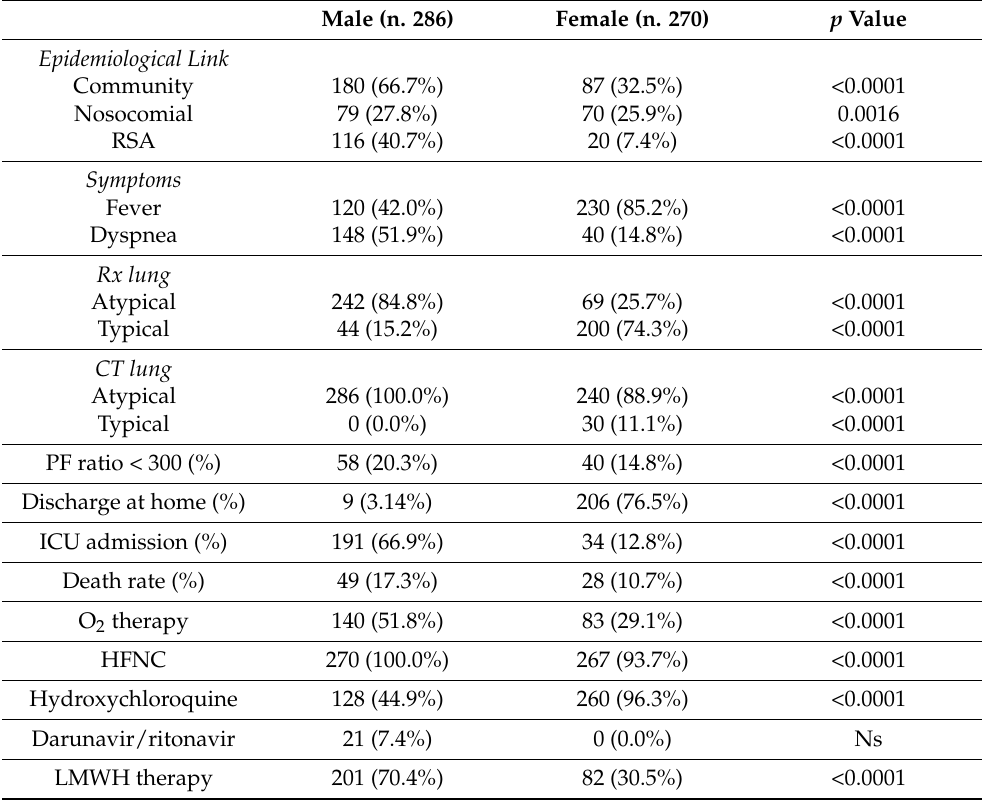
Table 3. Gender differences in DM-HT groups. ICU (intensive care unit), CT (computerized tomogra- phy), high-flow nasal cannula